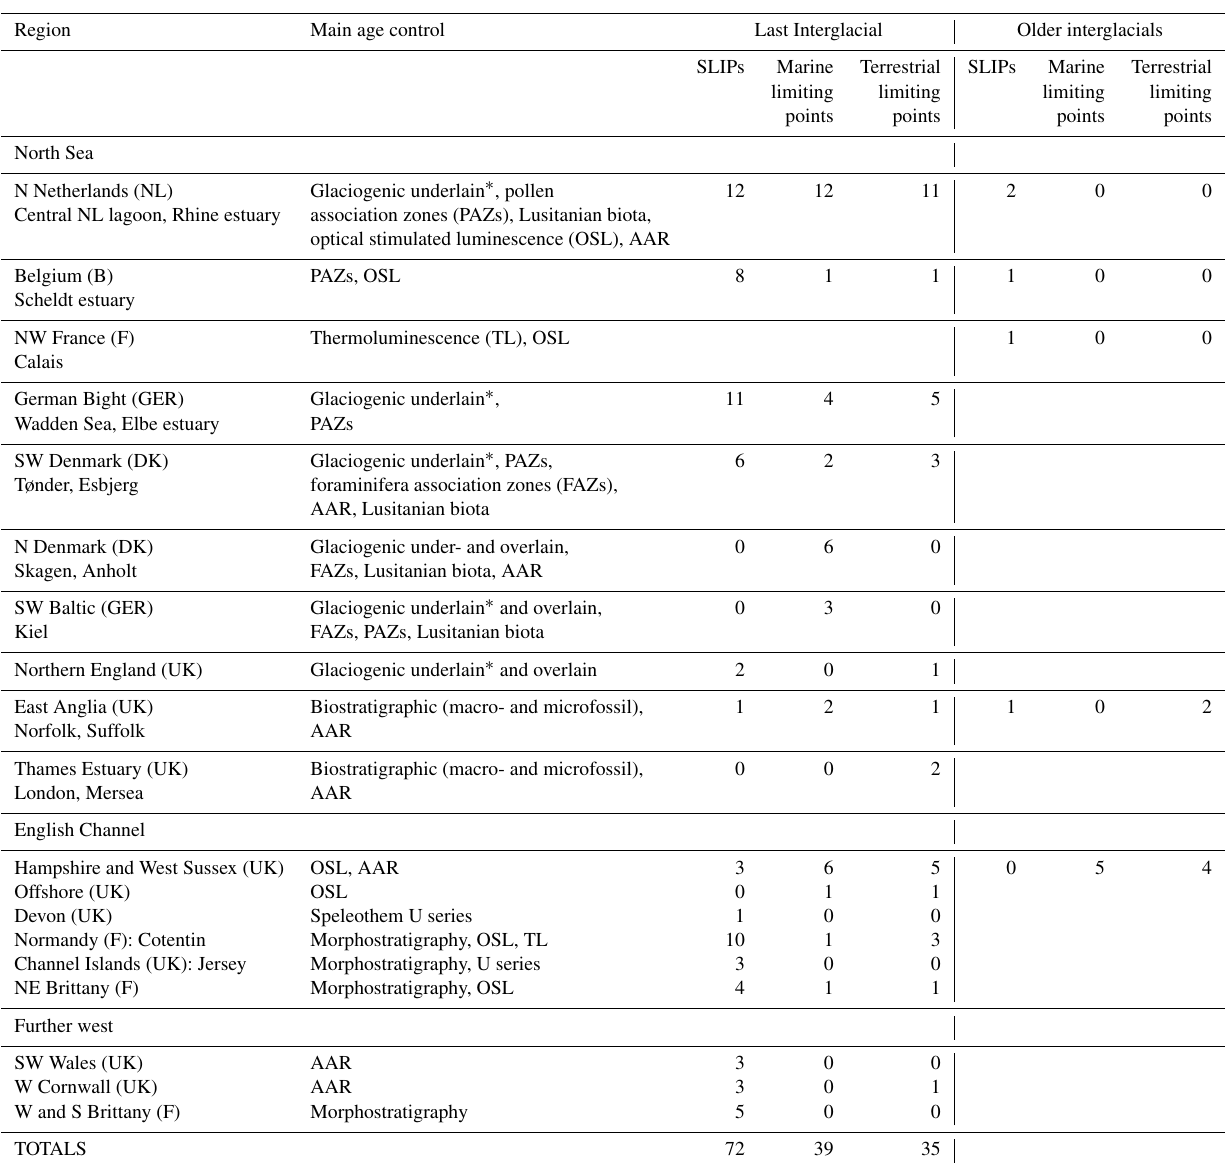
Table 2. NW Europe WALIS data point totals, split by region.